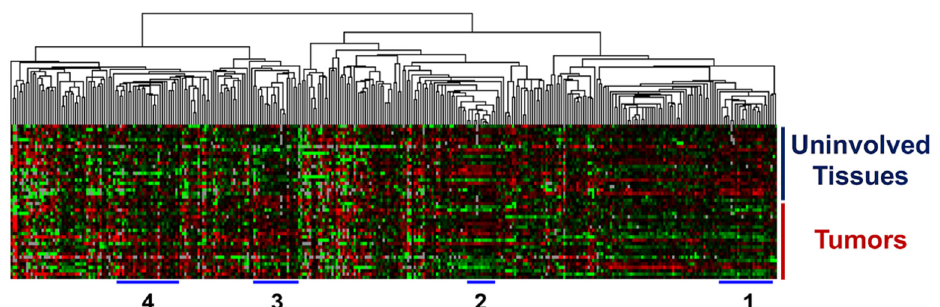
Figure 1. Clustering of miRNA expressions in tumor tissues and uninvolved prostate tissues. Hierar- chal clustering of log2-transformed relative expression values of miRNAs in uninvolved prostate and tumor tissues.